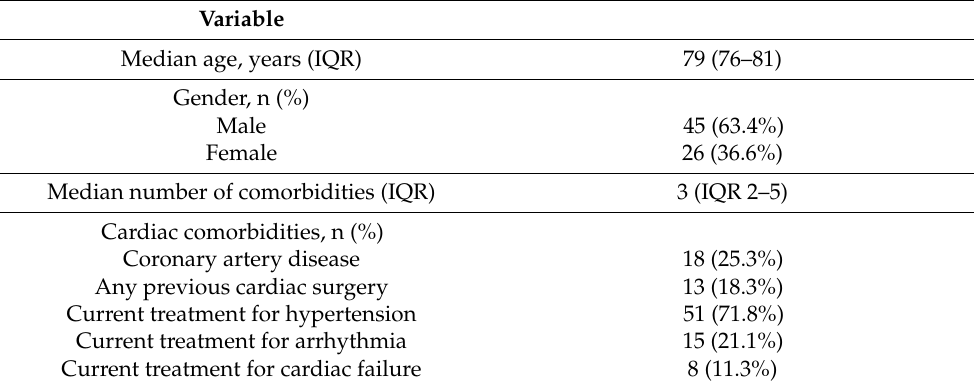
Table 2. Characteristics of the enrolled